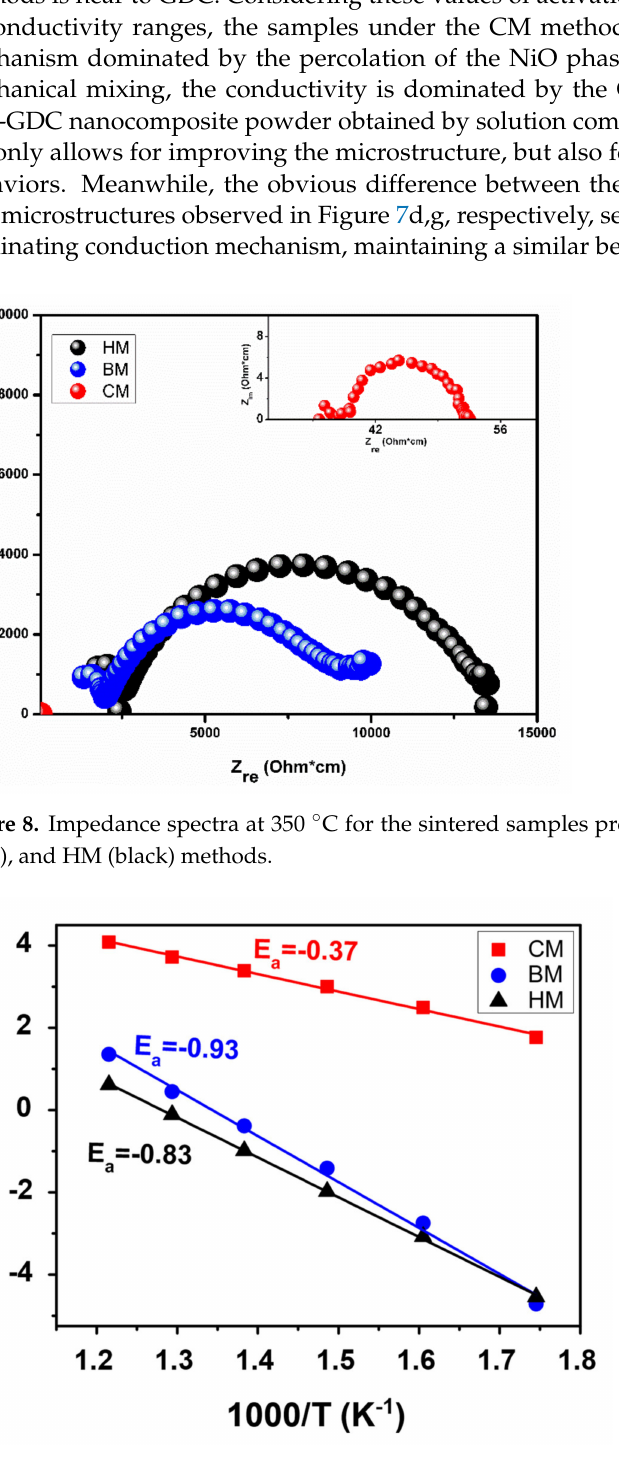
Figure 9. Arrhenius plots of total conductivity for the sintered samples processed through CM (red), BM (blue), and HM (black)